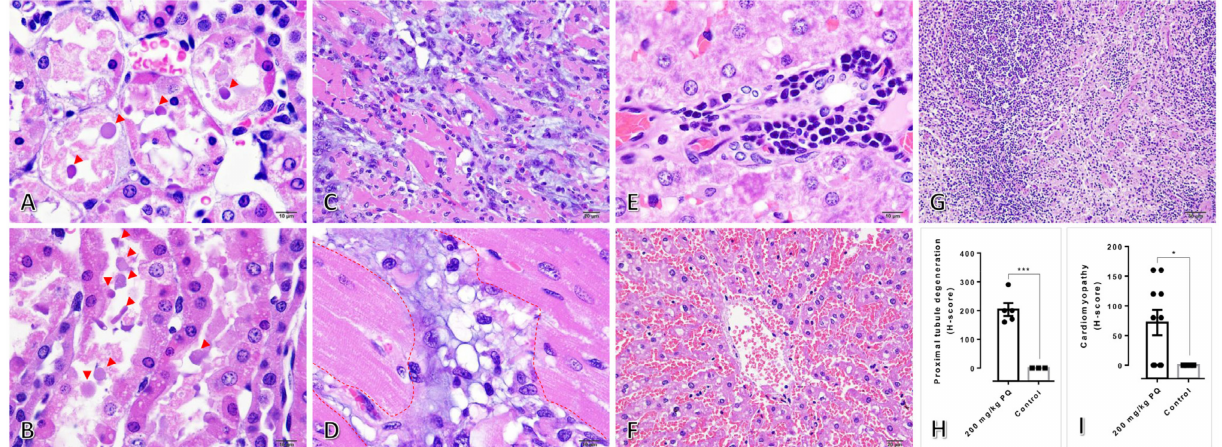
Figure 1. Histopathological changes in the kidney, heart, liver, and spleen in rat treated with 200 mg/kg of PQ: ( A ) Cross section of proximal convoluted tubules with extensive epithelial cell damage, pyknotic nuclei, and basophilic droplets deposition (arrow head). ( B ) Proximal convoluted tubules with longitudinal orientation exhibited vacuolated epithelial degeneration, nucleolar pykno- sis, eosinophilic cytoplasm, and luminal basophilic droplets accumulation (arrow head). ( C ) Car- diomyopathy characterized by diffuse interstitial fibrosis, extensive accumulation of mononuclear cells, and slight neutrophil accumulation. ( D ) A higher magnification of ( C ) highlighting the area of the histopathological lesion (red dotted-line). ( E ) The presence of extramedullary hematopoiesis revealed erythroid cell infiltration in the periportal region of the liver. ( F ) Sinusoidal space conges- tion space with red blood cells in the liver. ( G ) Intact spleen showed normal red and white pulps area. ( H , I ) Histopathological scores, respectively, for proximal tubular degeneration and ventricular cardiomyopathy (H&E staining). For subsequent figures, statistical significance of comparisons are *, p < 0.05 and ***, p < 0.0001.